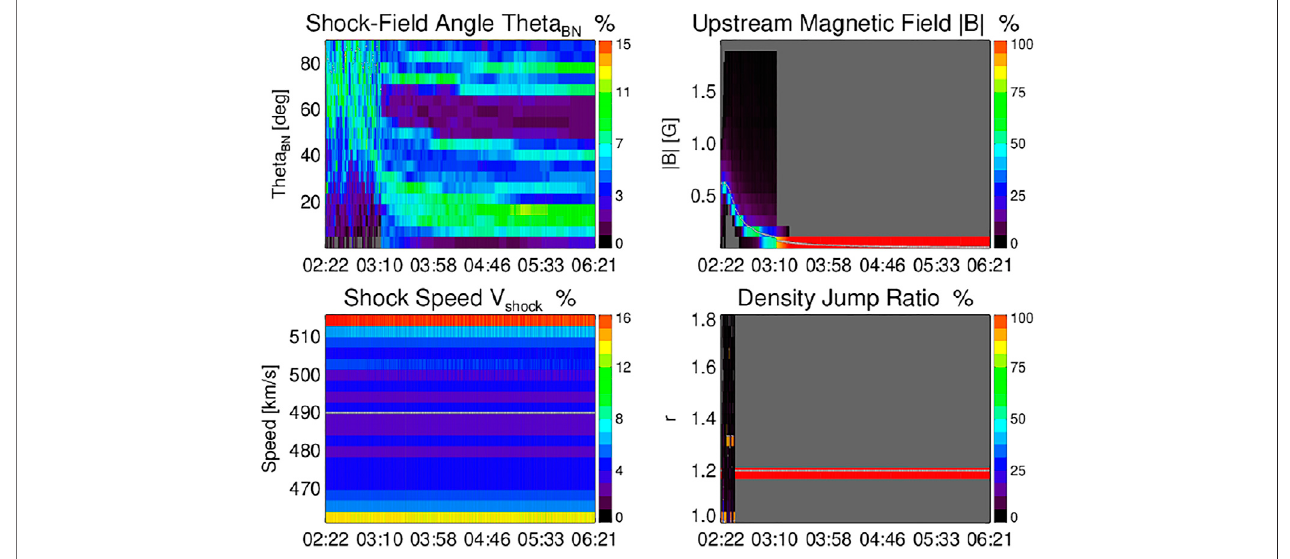
FIGURE 5 | A dynamic spectrum of the main parameters used for diffusive shock acceleration modeling, estimated at all shock-crossing fi eld lines for the May 11, 2011 event. This is a summary of the result presented in Figure 4 .